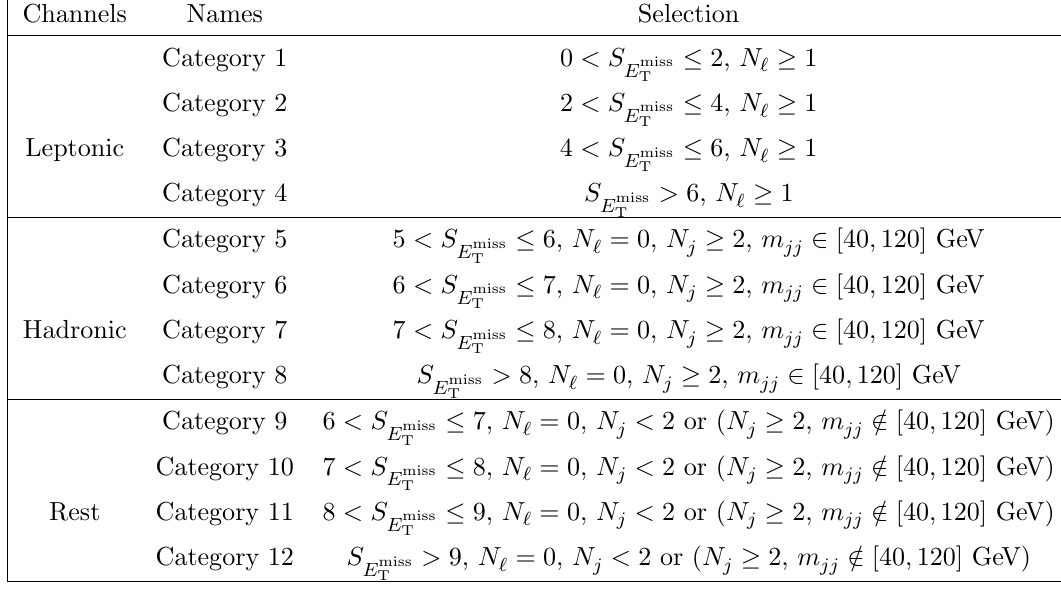
Table 1 . Criteria used in the